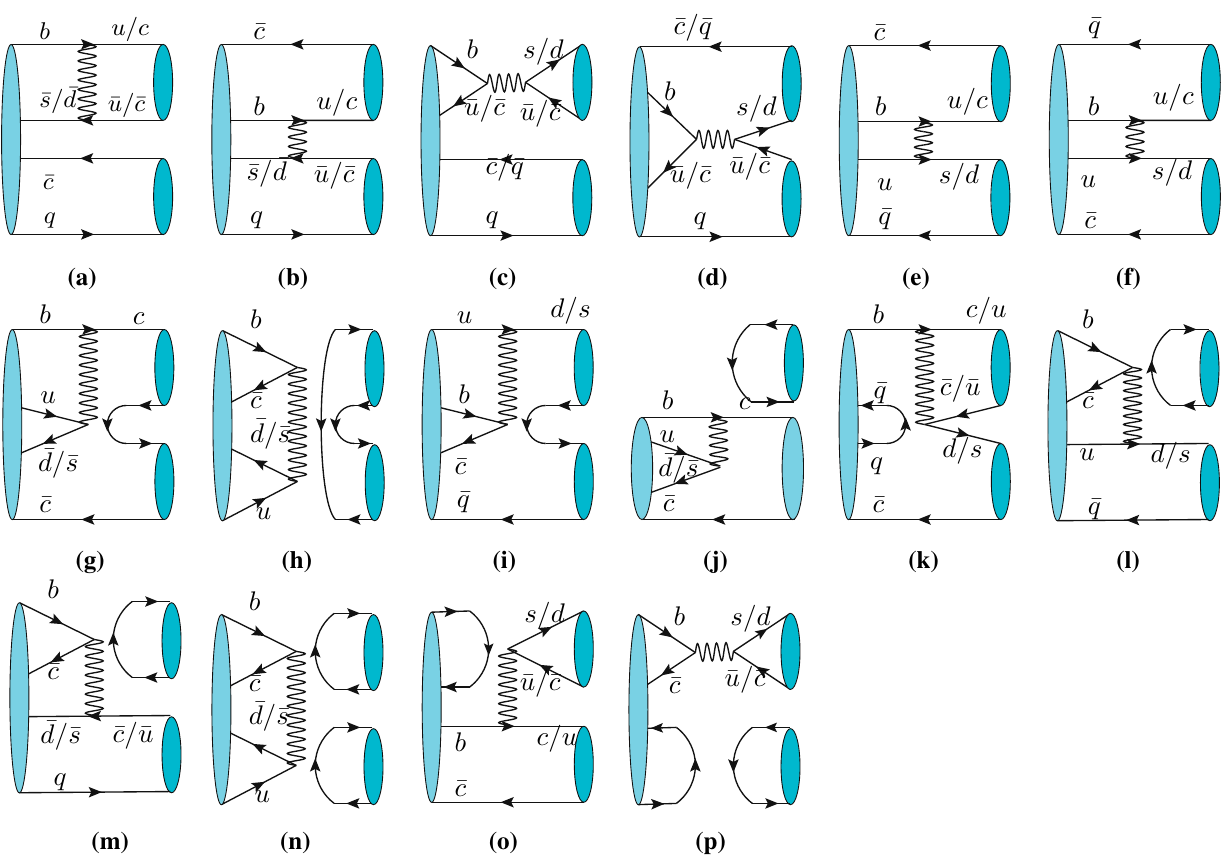
Fig. 2 Topological diagrams for the b -quark non-leptonic decays of tetraquark T b ¯ c 8 / T b ¯ c 1 . a – p Correspond to the decays into a pair of mesons. In j , l , m , n , p , the final meson produced by gluons is the